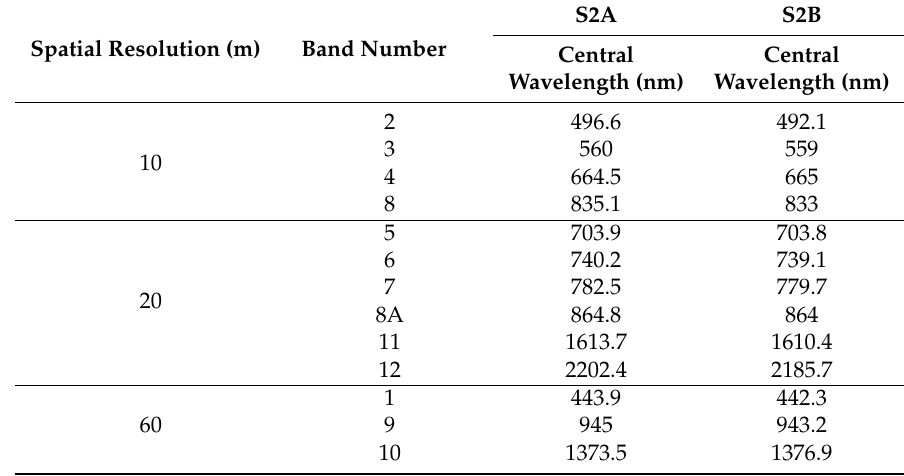
Table 1. Wavelengths of the three spatial resolutions of Sentinel-2.